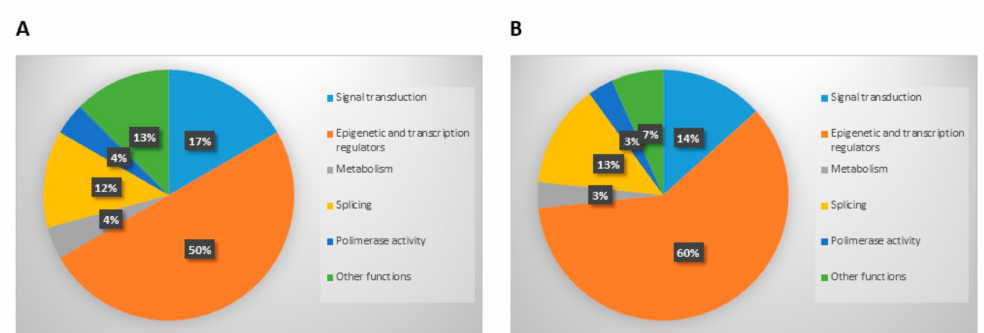
Figure 4. Graphic representation of the types of mutated genes, categorized on the bases of their biological main function, that were detected in cells ( A ) and on dsDNA derived from exosomes isolation ( B